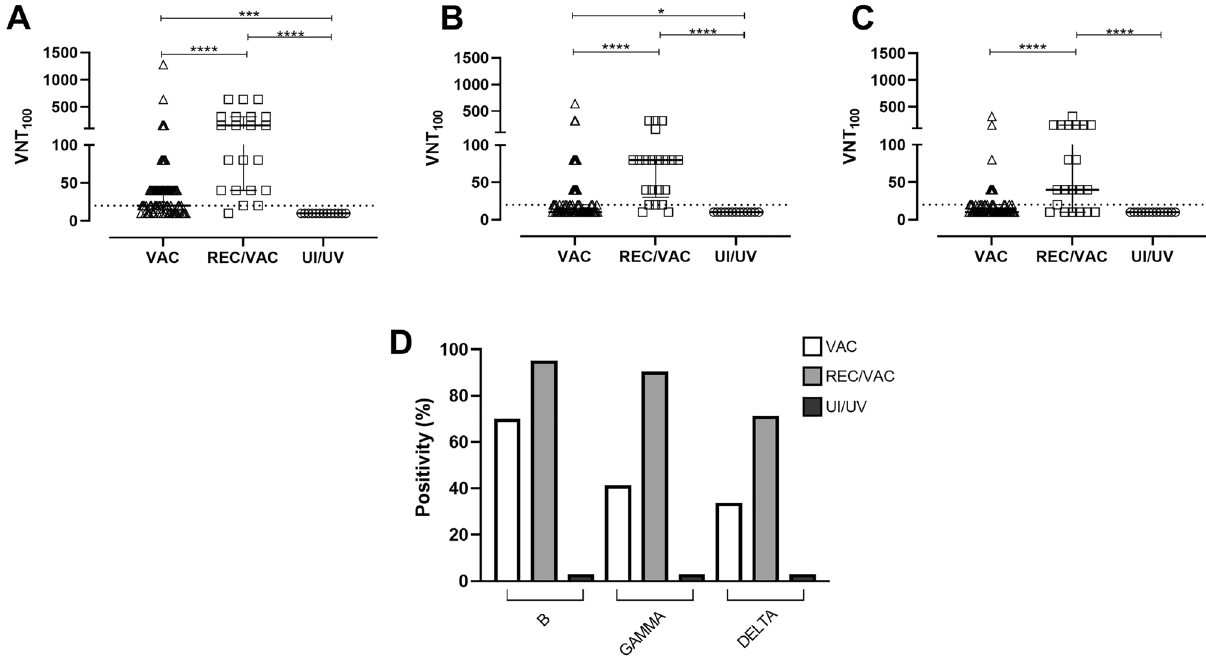
Figure 2. Neutralization of SARS CoV-2 lineages B, Gamma and Delta with serum from previously infected and/or vaccinated individuals, according to their VNT100. Serum obtained from COVID-19 vaccinated individuals (VAC) (n = 80; triangles), those recovered from COVID-19 and vaccinated (REC/VAC) (n = 21; squares) and negative control (UI/UV) individuals (n = 13; circles) were analysed to determine the virus neutralization titre (VNT 100 ) to the reference SARS-CoV-2 lineage B ( A ); Gamma ( B ) and Delta ( C ) variants. Scatter plots show lines at the median with interquartile ranges. The dashed lines represent the cut-off value for the test (20 VNT 100 ). One-way ANOVA and the nonparametric Kruskal–Wallis test were used to compare the study groups. Asterisks denote statistical significance between the groups (* p < 0.05; *** p < 0.001; **** p < 0.0001). Bar graphs represent the percentage of responders to each variant ( D ).